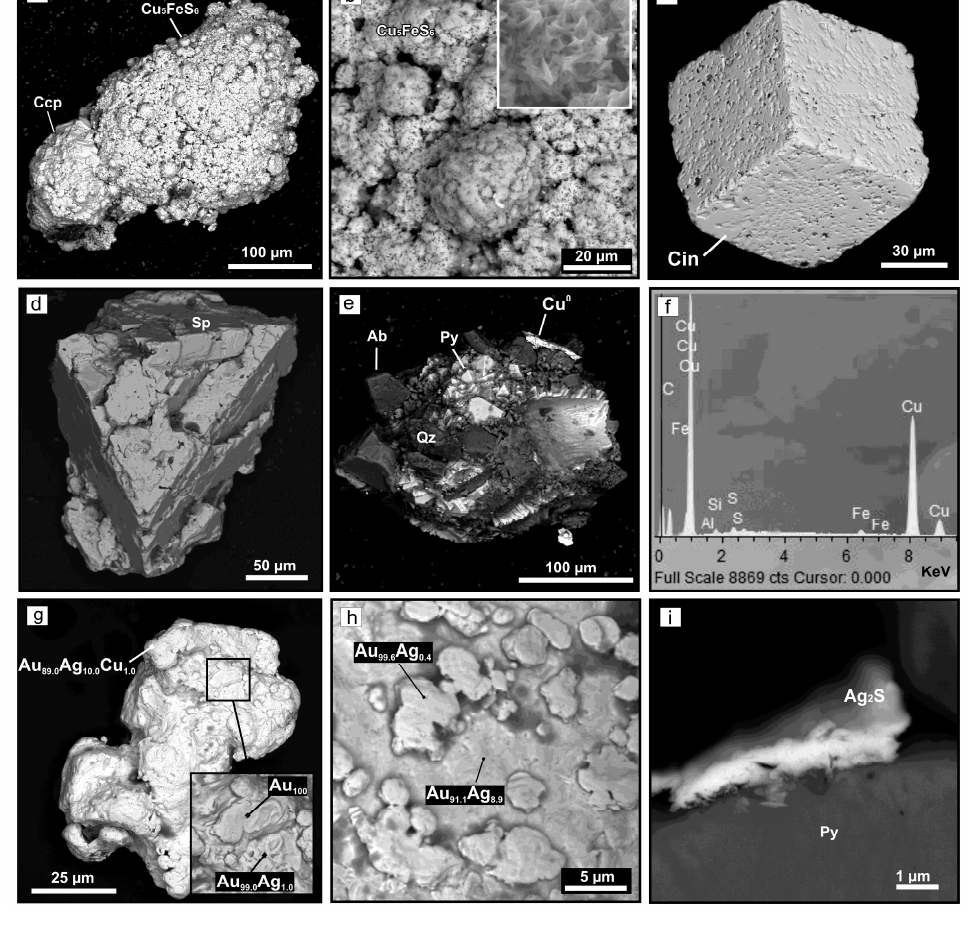
Figure 12. Morphology of copper sulphides, cinnabar, sphalerite, silver sulphide and native elements from mud masses (Bulganak area). ( a , b ) Intergrowth of chalcopyrite and Cu–Fe-sulphide (close to Cu 5 FeS 6 -stoichiometry). Chalcopyrite forms tetrahedrons. Cu 5 FeS 6 occurs as reniform aggregate consisting of numerous star-like microliths with orthorhombic (?) symmetry ( b ); ( c ) Euhedral crystal of cinnabar with sharp edges and vertices; ( d ) Sphalerite tetrahedron with sharp edges and vertices; ( e ) Thin plate of copper coexisting with pyrite, Fe-(oxy)hydroxides, quartz and detrital albite; ( f ) EDS spectrum of copper; ( g , h ) An irregular particles of Au–Ag alloy decorated by later pancake-like overgrowths of gold; ( i ) Aggregate of silver sulphide (Ag 2 S) coating a pyrite crystal. ( a – e , g – i ) BSE images. Ab = albite; Ccp = chalcopyrite; Cin = cinnabar; Cu 0 = copper; Sp = sphalerite; Qz = quartz. ( a – c , e , g , h ) = Tischenko Hill; ( d , i ) = Andrusov Hill. Framboids are mostly spherical with diameters from 5 to 50 µm (10–20 µm on average) and consist of spherical, cubic, cubic-octahedral, or more rarely octahedral crystallites, with sizes from 0.5 to 3 µm (Figure 7), arranged most often in an ordered way (sometimes with shared orientations) and rarely with distinct pentagonal or trigonal symmetry (Figure 7b). Some framboids are composed of randomly aggregated crystals. Most of framboids contain intergrown crystallites (filled), while some are open and composed of discrete particles. The space between framboids (both primary and recrystallised) is frequently filled with matrix material (Figure 7b,c).